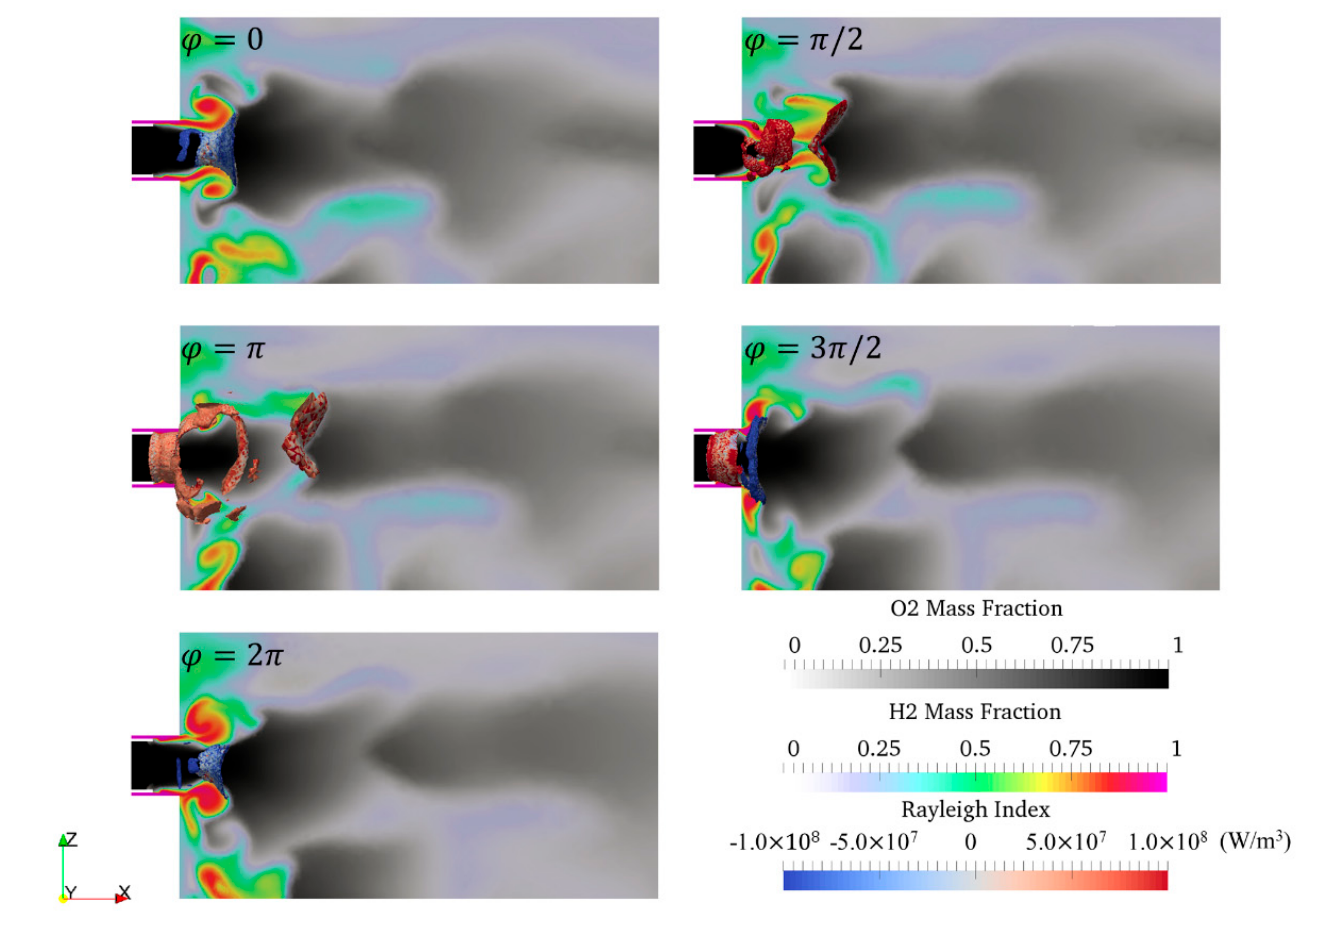
Figure 16. Iso-surface of the Rayleigh index by phase change at the analysis plane of injector B in one period of the cycles, overlapped with the oxygen and hydrogen mass fraction contours.